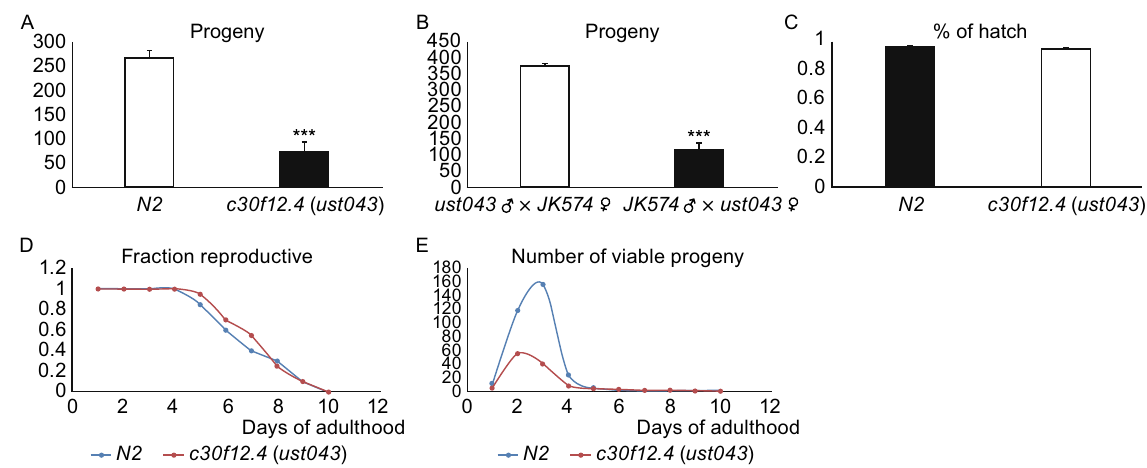
Figure 2. Disruption of c30f12 .4 causes female sterility in worms. (A) Brood size of wild-type or mutant worms was determined at 20 °C. The x-axis indicates corresponding genotypes; the y axis is the mean value of total number of progeny per animal. Greater than six animals per trial, average of three trials. *** P < 0.001, t -test. (B) The number of progeny after mating between fog-2 ( JK574 ) and c30f12.4 ( ust043 ). Four animals per trial, average of three trials. *** P < 0.001, t -test. (C) Percentage of embryos hatched after laying from day two wild-type and c30f12.4 adults. Greater than 500 eggs per trial, average of three trials. (D) Reproductive span of wild-type and c30f12.4. Ten animals per trial, average of three trials. (E) C30f12.4 mutants produce fewer early and total progeny than wild type. Ten animals per trial, average of three